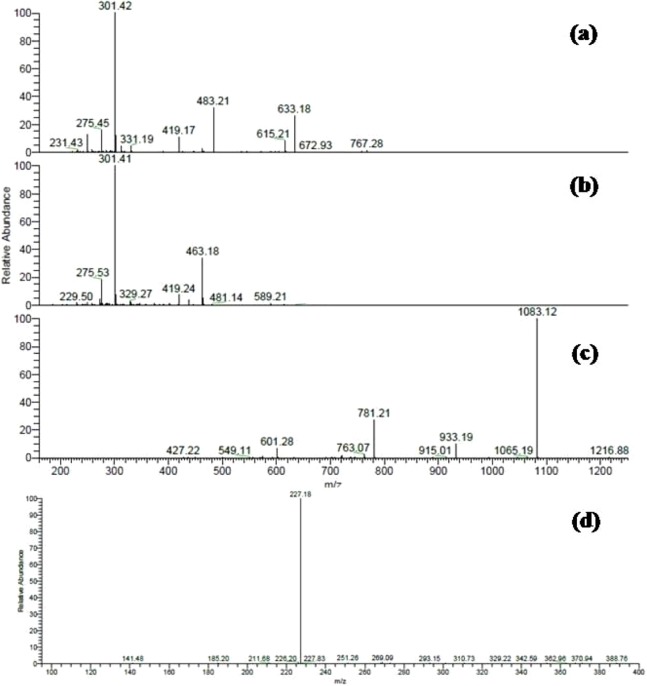
ESI-MS/MS spectra of some selected compounds in the extracts.ESI-MS/MS of (A) Digalloyl-HHDP-hexoside [M – H]− at m/z 785; (B) Corilagin [M – H]− at m/z 633; (C) Galloylpunicalagin [M – H]− at m/z 1235; (D) Resveratrol glucoside [M – H]− at m/z 389.